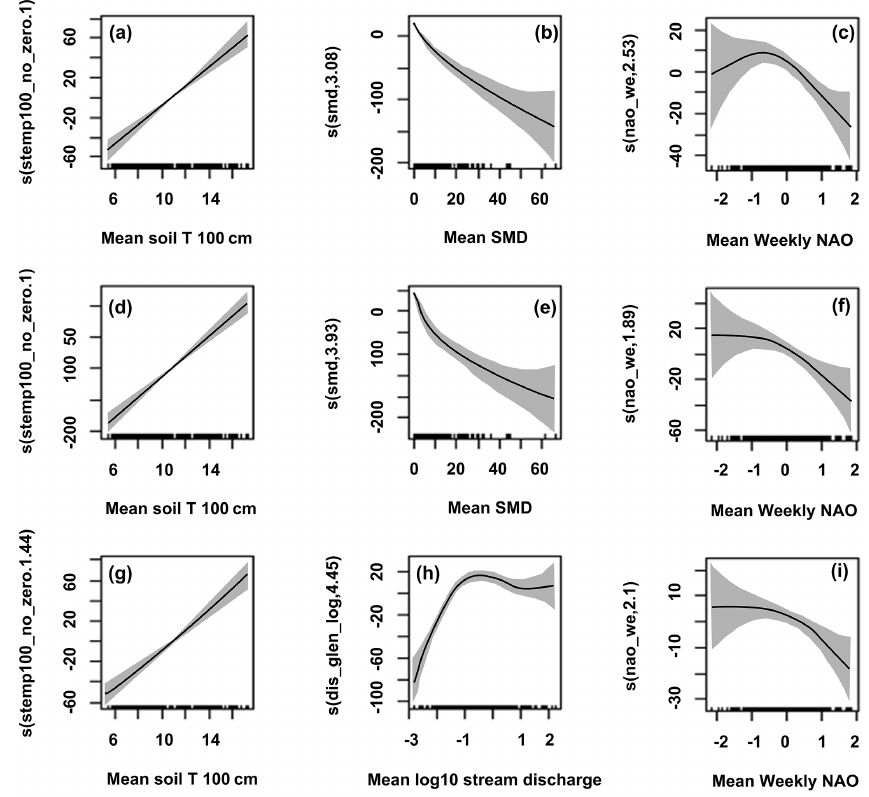
Figure 4. Selected smoothers for the contribution of explanatory variables for the optimal GAMM explaining water colour in each sub- catchment river: Black ( a–c ): (a) soil temperature, (b) soil moisture deficit (SMD) and (c) NAO; Srahrevagh ( d–f ): (d) soil temperature, (e) soil moisture deficit and (f) weekly NAO; Glenamong ( g–i ): (g) soil temperature, (h) log of discharge and (i) NAO. The solid line is the smoother, and the shaded area shows the 95% confidence bands. The y axis units are the scaled smoother (s) for each explanatory variable with the variable name followed by the estimated degrees of freedom within the